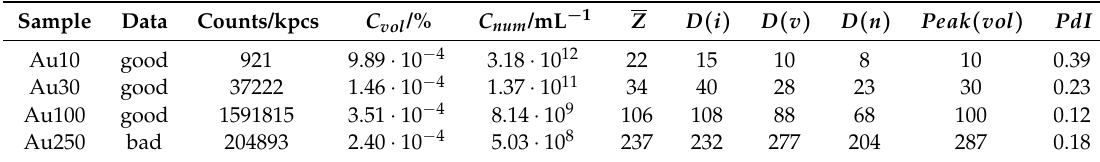
Table A4. Results from the standard resolution algorithm.